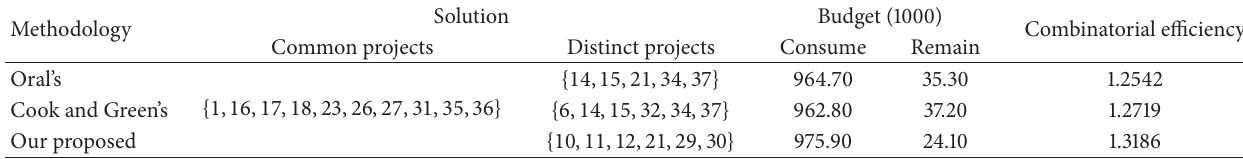
Table 7: Combinatorial efficiency evaluation of Example 2.